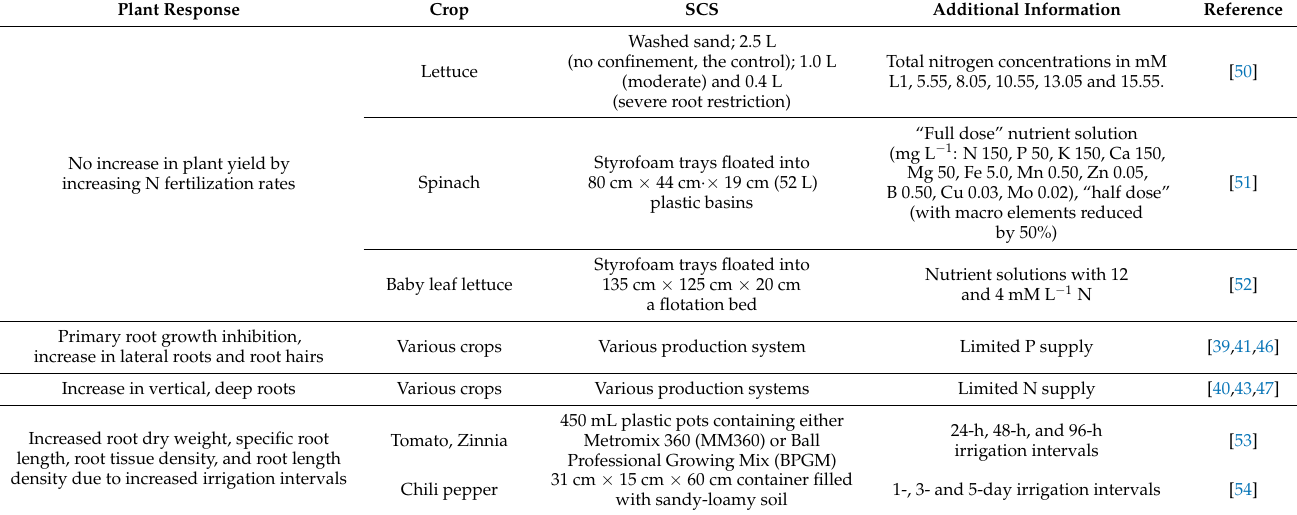
Table 2. Plant responses to nutrient